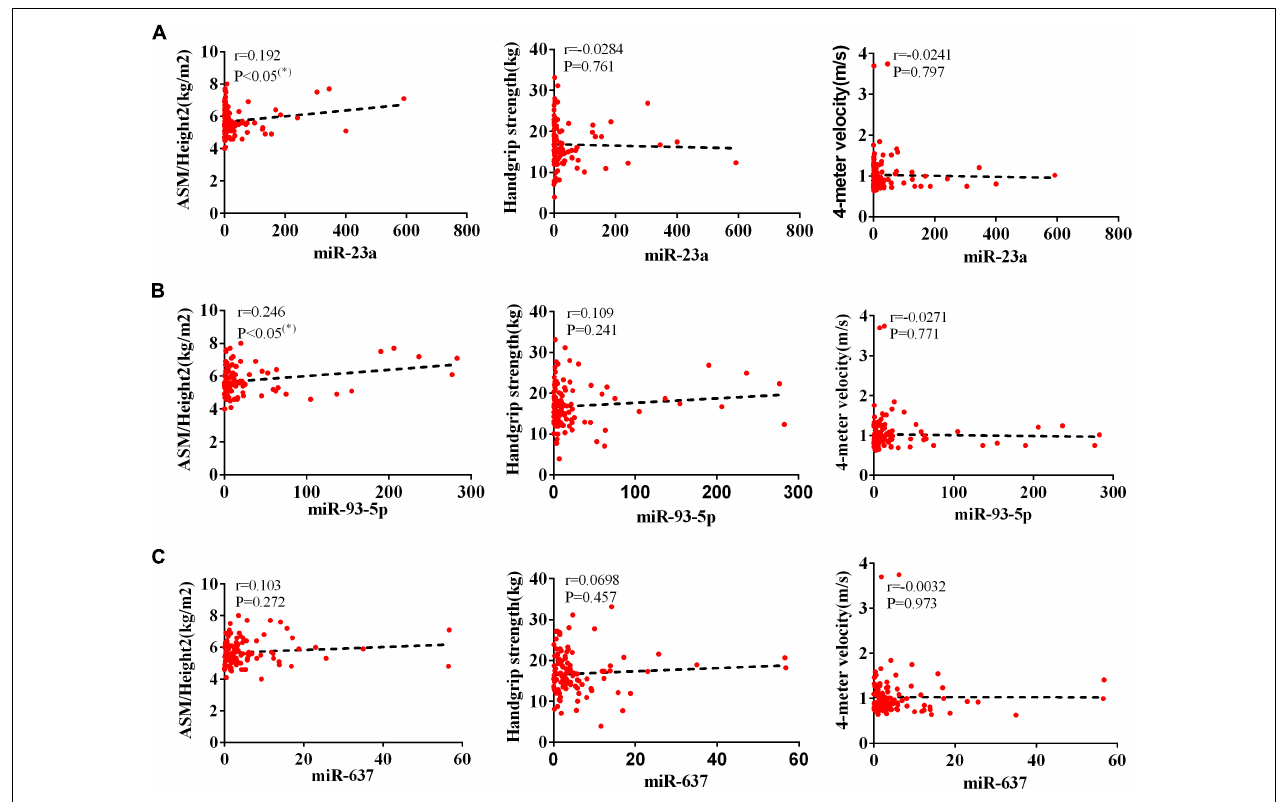
FIGURE 4 | Correlation analysis between the changes in (A) miR-23a-3p, (B) miR-93-5p, and (C) miR-637 and ASM/height 2 (kg/m 2 ), handgrip strength (kg), and 4-m velocity (m/s) in women. The correlation analysis of miR-23a-3p and miR-93-5p and miR-637 with these indicators in female subjects. Pearson’s method was used for correlation analyses; * P < 0.05; n =